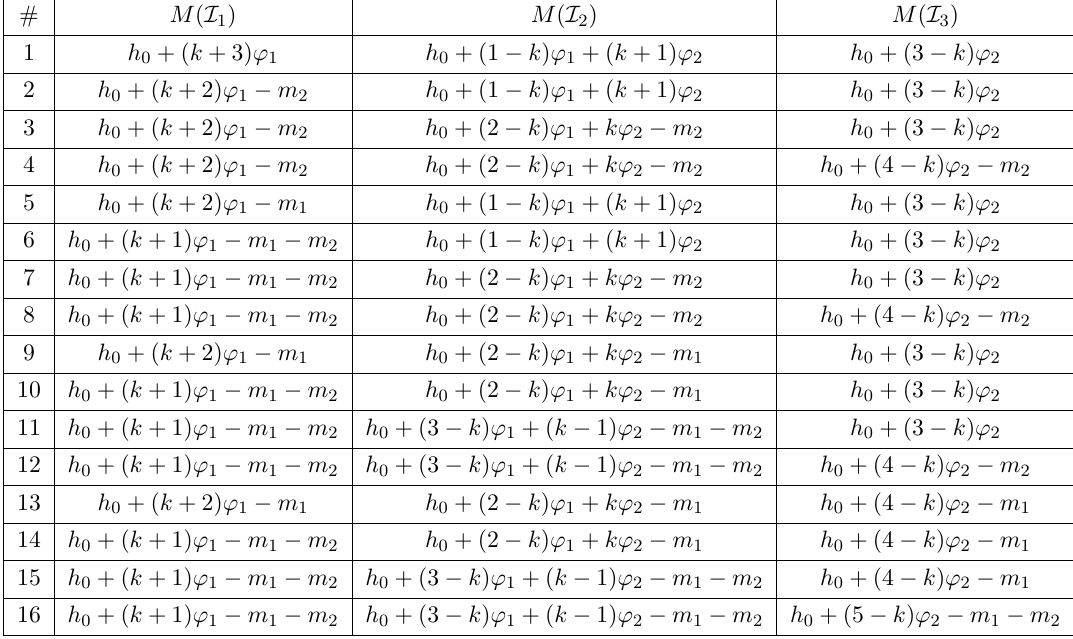
N f = 2 (cid:12)eld theory. eff